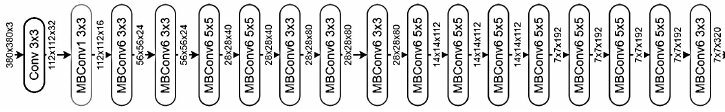
Figure 2. Schematic illustration of EfficientNet-B0